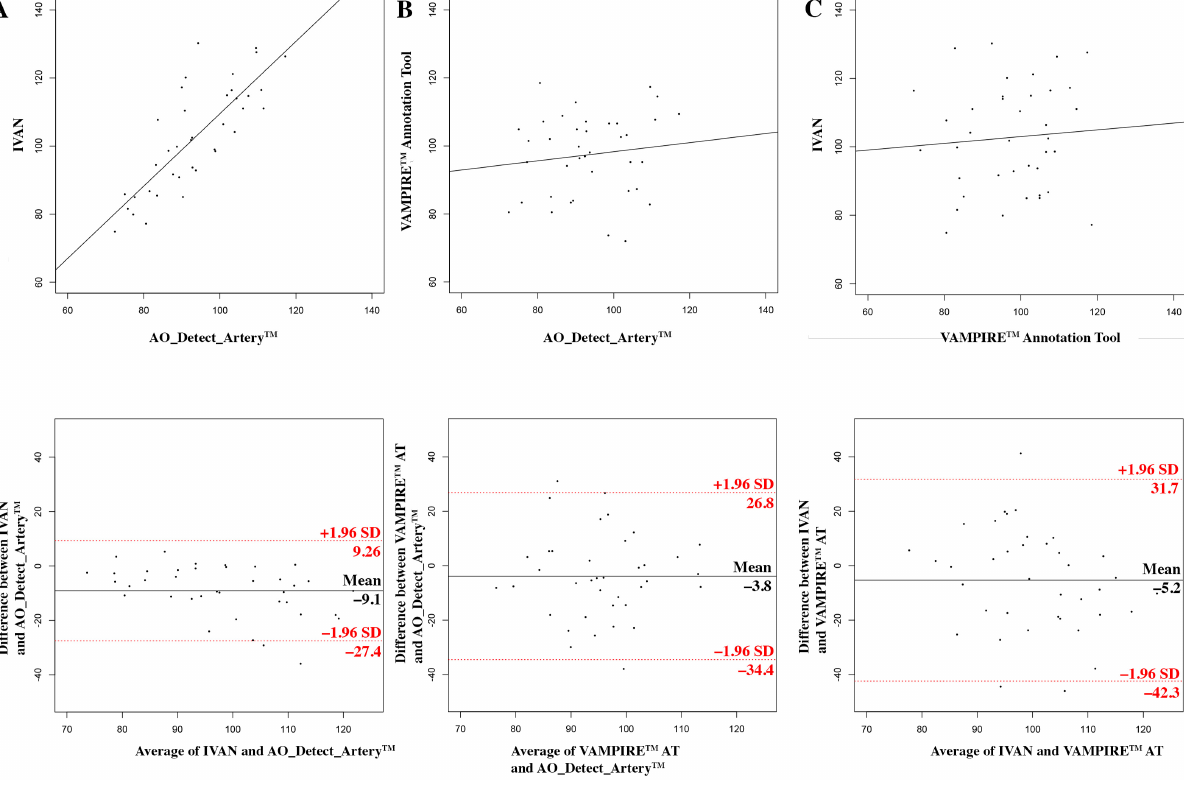
Figure 3. Measurements of retinal artery lumens using AO and fundus camera images. Top row: scatter plots of vessel diameter measurements with the result of the Pearson correlation tests.